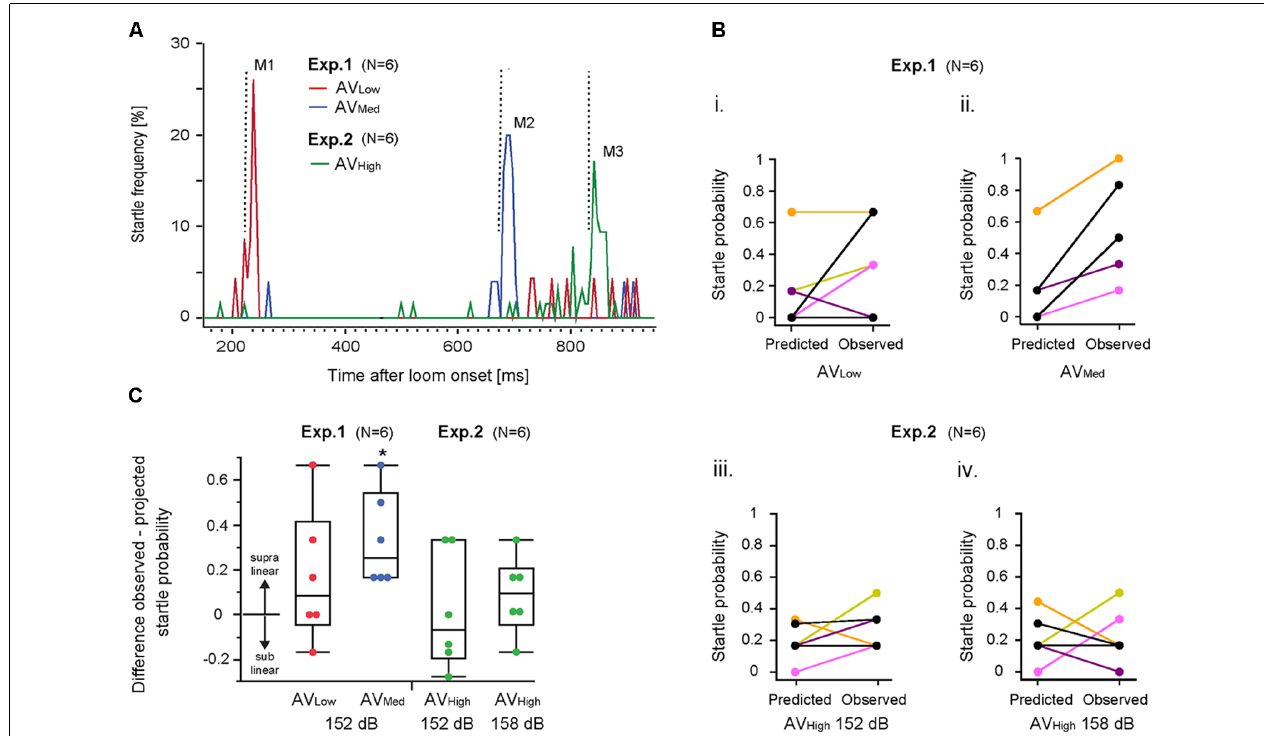
FIGURE 2 | Multimodal integration in the M-cell startle system. (A) Line graph illustrates startle frequency plotted against visual loom duration for all three audio-visual (AV) stimulus paradigms. M1, M2, M3 represent distinct frequency modes for AV Low and AV Med or AV High trials, respectively. Vertical dotted lines indicate onset of the auditory stimulus. (B) Graph illustrates observed and predicted individual startle escape probability for AV Low and AV Med stimulus paradigms using an auditory stimulus of 152 dB re 1 µ Pa in water (i,ii) and the AV High paradigms involving auditory stimuli of 152 dB re 1 µ Pa in water ( iii ) and 158 dB re 1 µ Pa in water (iv) . Predicted startle escape probabilities were based on linear summation of response probabilities evoked in unimodal visual only and auditory only stimulus trials. Note: fish overlap in (Bii) . (C) Box plots of differences between observed minus predicted startle escape response probabilities for the indicated AV stimulus paradigm ( ∗ p = 0.043, one-sample t -test with a test value of 0, i.e., linear summation; N =